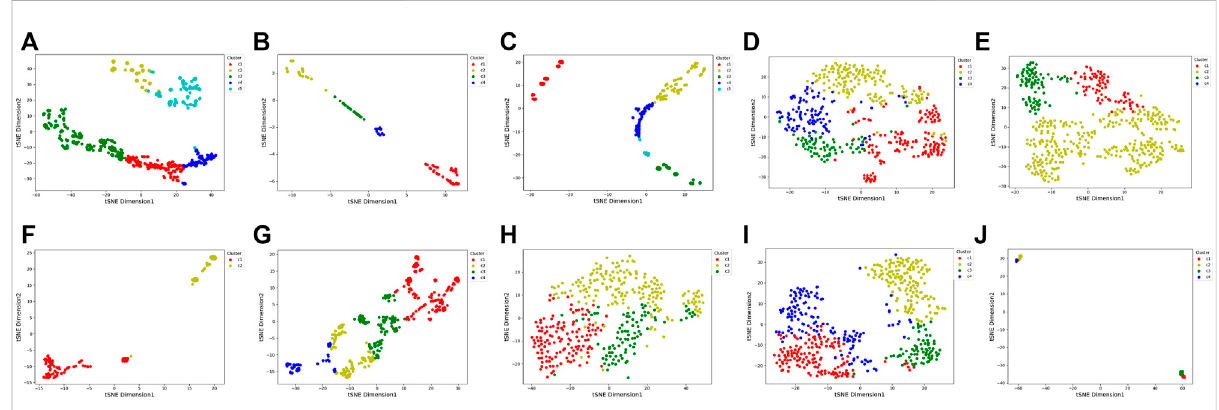
FIGURE 5 t-SNE visualization of the fi nal integrated features by SADLN on ten cancer datasets. (A) BRCA, (B) BLCA, (C) GBM, (D) KIRC, (E) LUAD, (F) PAAD, (G) SKCM, (H) STAD, (I) UCEC, (J) UVM.